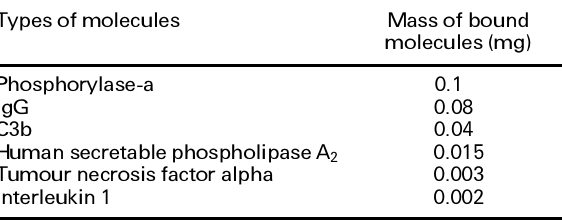
Table 3. Binding of molecules by 1 mg of insoluble glyco- gen (ISG). Data represent the average values of two repeated binding experiments with duplicated samples ( n = 4) Types of molecules